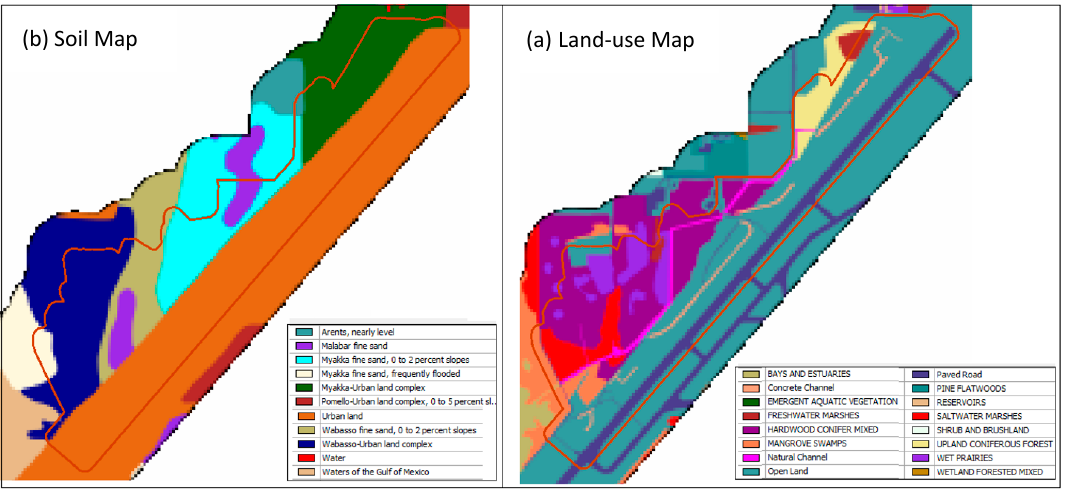
Figure 2. Natural Resource Conservation Service (NRCS) soil map ( a ) and SFWMD land-use map ( b ). Tide data for a nearby Tampa Bay gage (station ID 8726520) were obtained from NOAA to set the sea level boundary conditions for this study. The mean high water elevation (MHW) is 0.6 m (1.98